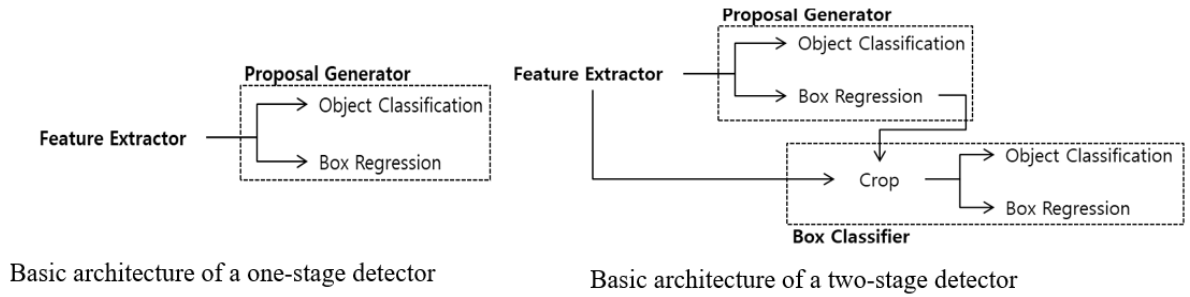
Figure 1. Basic structures of one-stage and two-stage detectors.